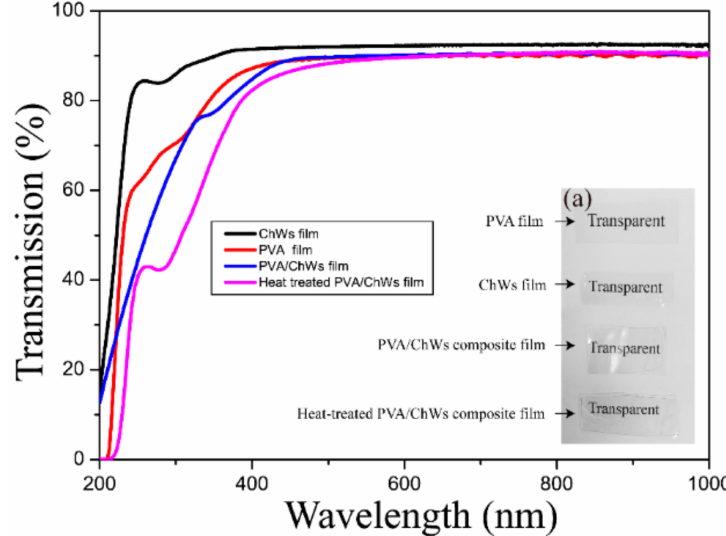
Figure 6. (a) Photographic images and UV–vis spectra of the pure PVA film, ChWs film, PVA/ChWs composite film and heat treated PVA/ChWs composite